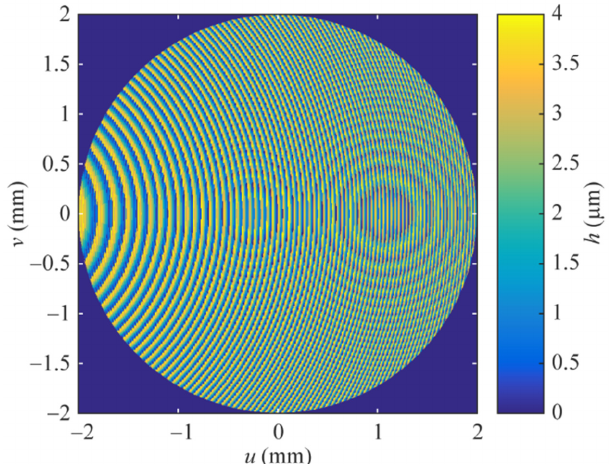
Figure 1. Microrelief of the MWDL focusing the wavelengths λ 1 = 455 nm and λ 2 = 750 nm to points. two